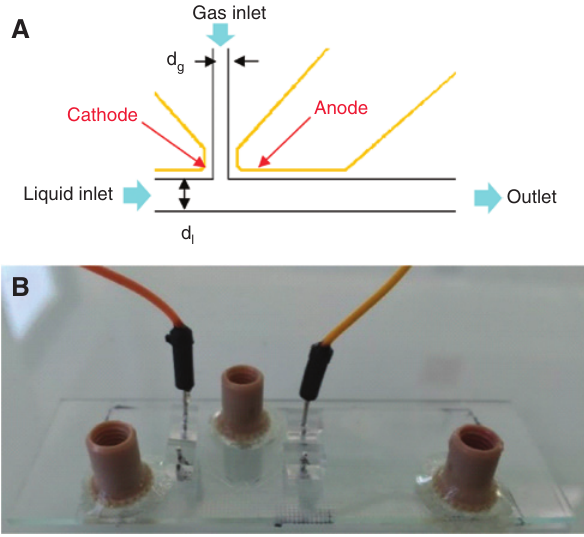
Figure 2: Schematic drawing (A) and image (B) of a T-junction plasma microreactor.